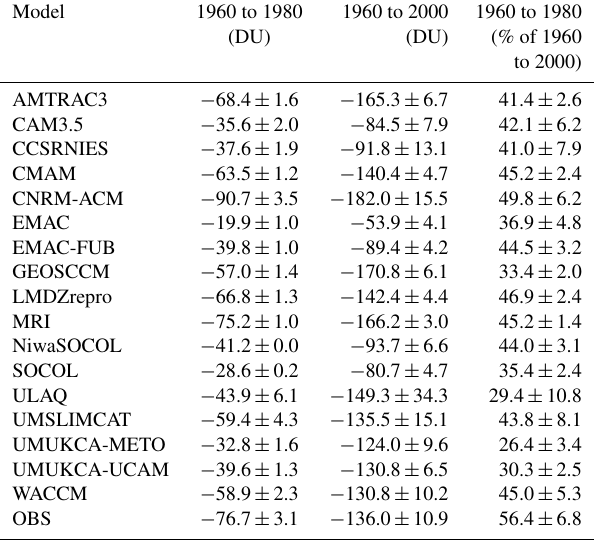
Figure 5. Antarctic temperature in 100hPa (in ◦ C, September– October–November average) between 1960 and 2000 in REF- B1 CCM simulations (coloured lines) and observations (black). Temperatures have been constructed by combining the offset and linear trend coefficients of a regression model similar to Eq. (1) ap- plied piecewise to two periods from 1960 to 1980 and 1980 to 2000. Table 2. Halogen-induced Antarctic ozone depletion in DU in CCM simulations and observations for the periods 1960 to 1980 and 1960 to 2000. Uncertainties of 1 σ were derived by applying error prop- agation rules. The rightmost column indicates changes from 1960 to 1980 as percentage of the changes from 1960 to 2000.